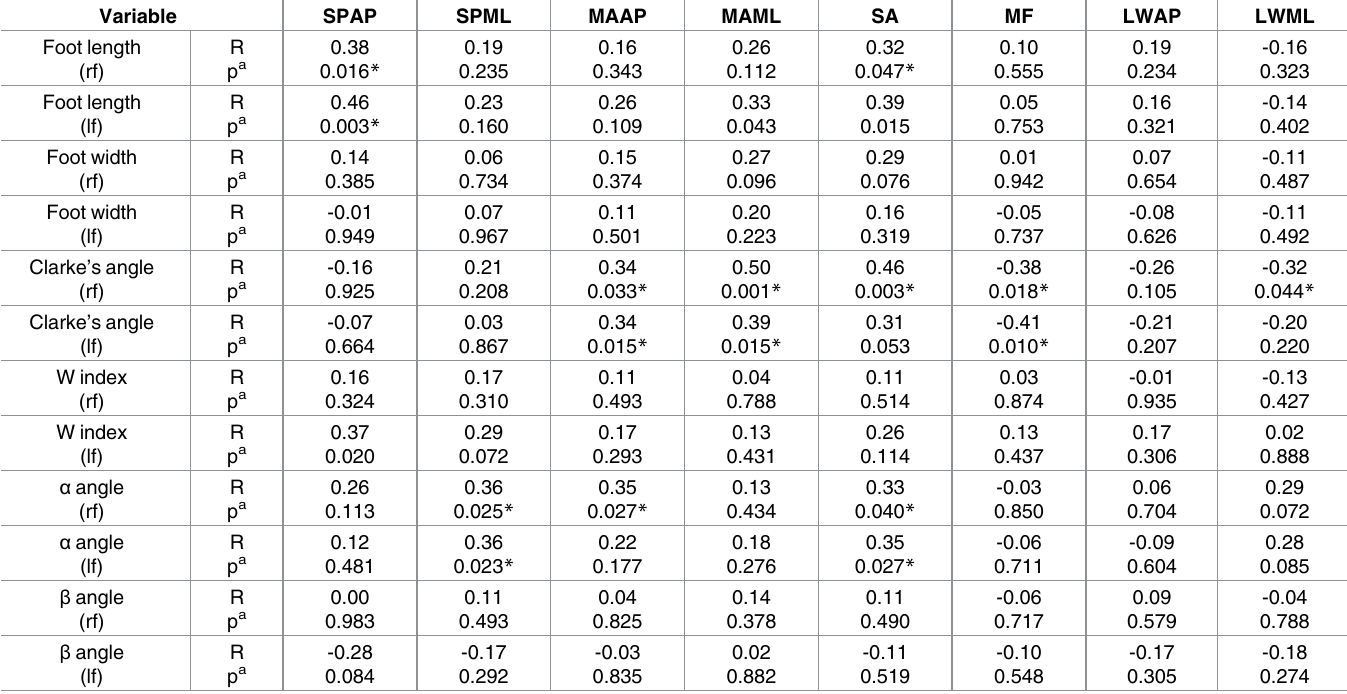
Table 4. Correlations between structural features of the feet and the stability indicators in the male study subjects.